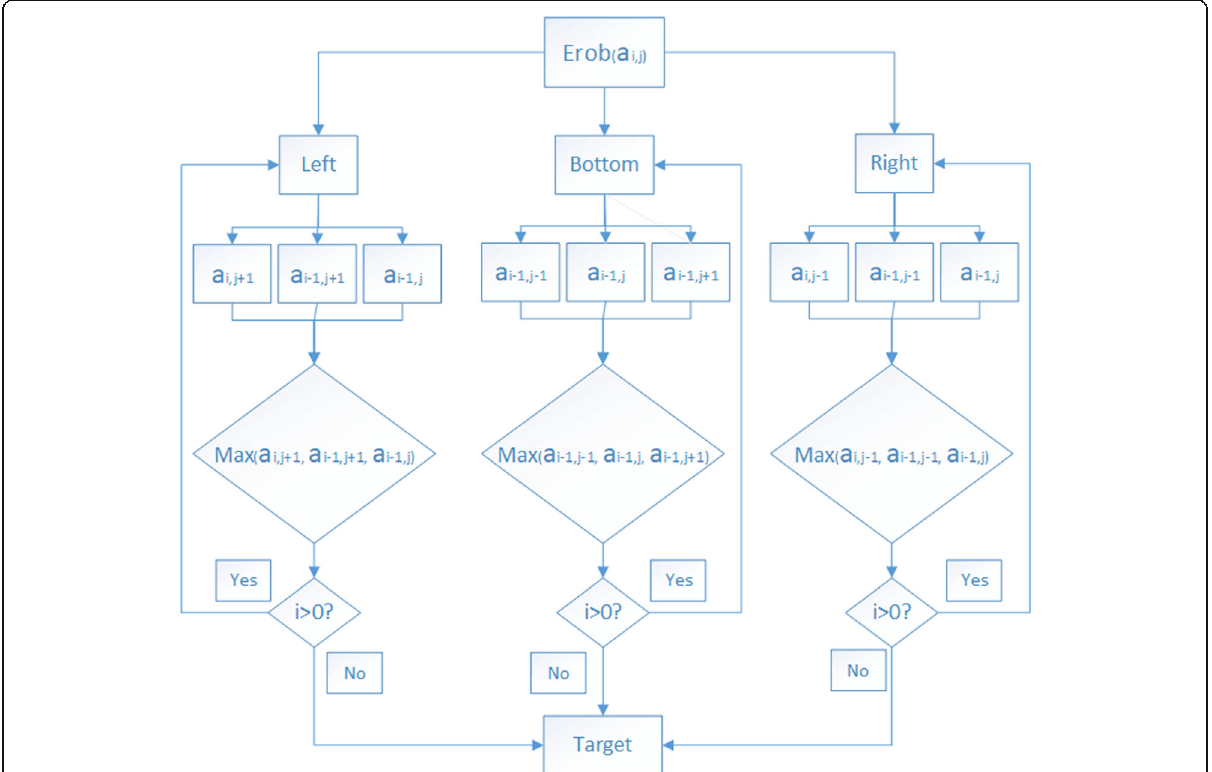
Fig. 12 RSS energy-enhanced depth-first algorithm. Erob enters the positioning area from the left, middle, and right, respectively, and makes routing decisions based on the energy changes